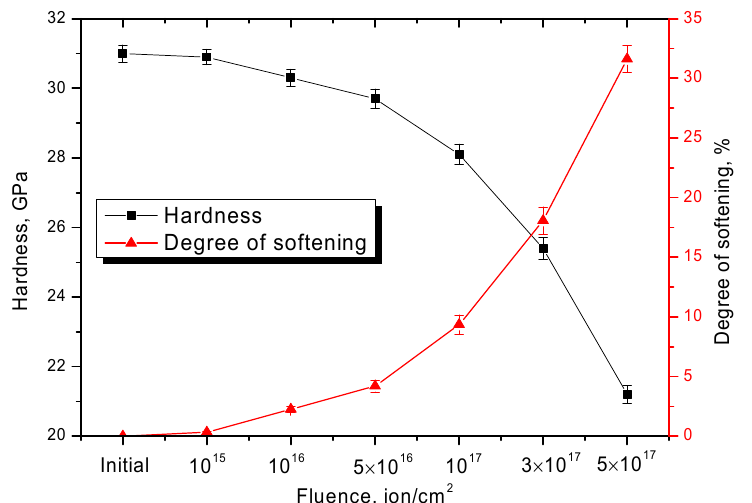
Figure 10. Results of changes in the damaged near-surface layer hardness and softening degree depending on irradiation fluence.